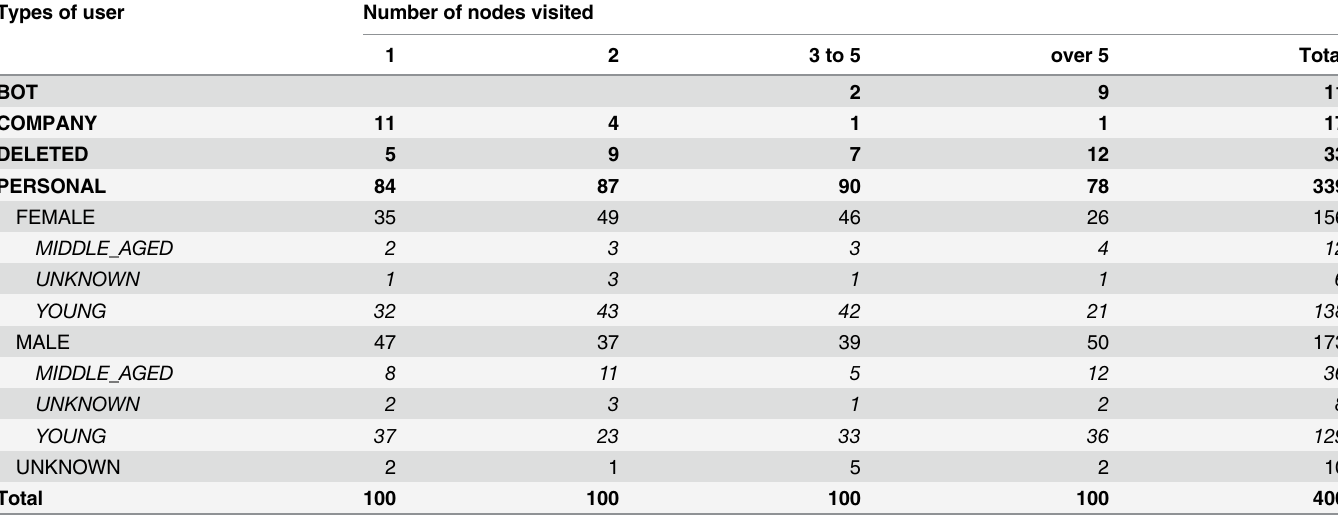
Table 3. Results of sampling Twitter users with differing movement